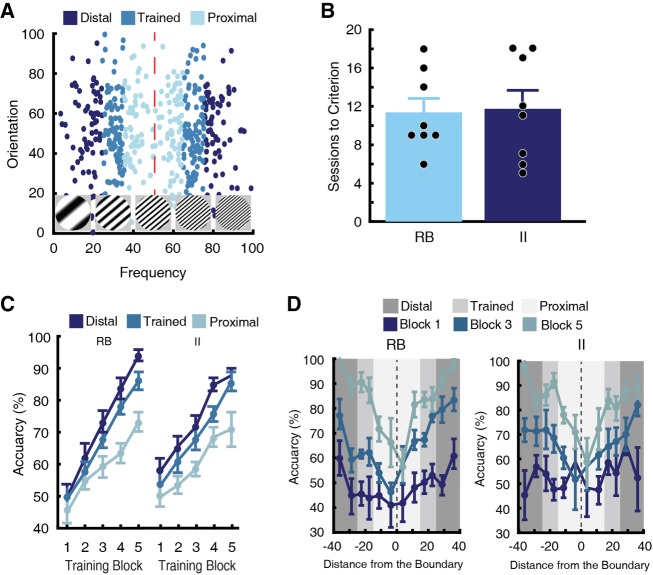
(A) Category tasks used in Experiment 2. These distributions had identical means and SDs to the testing distributions of Experiment 1. (B) The mean number of sessions to reach the learning criterion for rats learning the RB and II tasks. Similar to Experiment 1, there was no difference in the rate of learning between tasks. (C) Accuracy across training for rats learning RB and II tasks. The training sessions were first vincintized so that each rat's learning curve was averaged into five training blocks. There was no difference in accuracy across training between rats learning RB tasks and rats learning II tasks. For both groups, accuracy increased for Distal stimuli and decreased for Proximal stimuli compared to Trained stimuli. (D) Accuracy was calculated according to the distance from the category boundary at difference stages of the animal's training (Blocks 1, 3, and 5). For rats learning RB tasks (left) and II tasks (right), performance started at chance. By the end of training, accuracy increased as a function of distance from the category boundary.